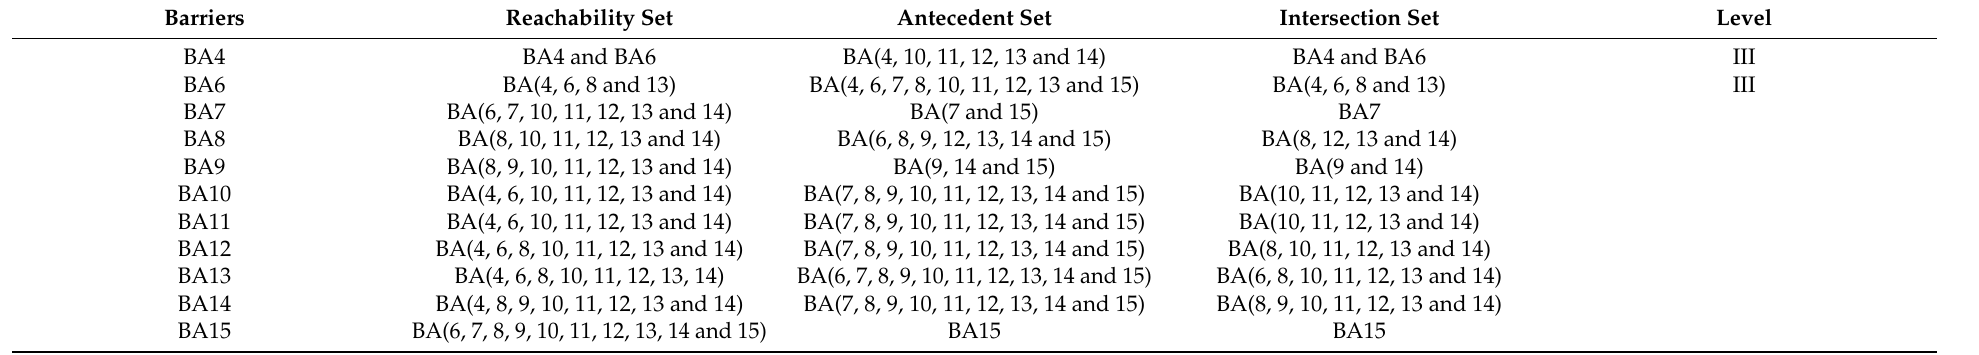
Table 11. Level III partition of the hierarchical structure of the barriers using a final reachability matrix.